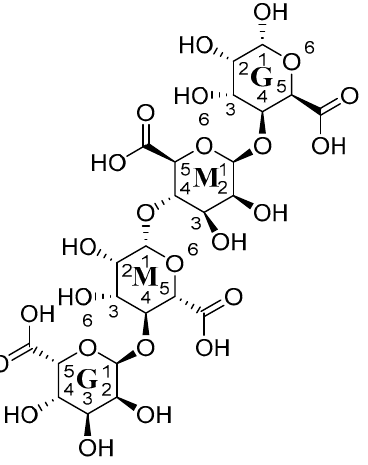
Figure 14. A molecules formed of several G and M .